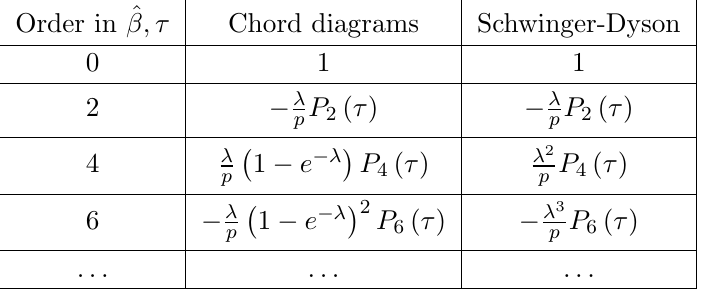
Table 2. Dominant contributions at small (cid:21) and p (cid:0) 1 for the high temperature, low time regime of the two-point function of a single fermion i in SYK. The polynomials P i ( (cid:28) ) have been introduced to keep the notation compact. Their expressions are: P 2 ( (cid:28) ) (cid:17) ^ (cid:12)(cid:28) , P 4 ( (cid:28) ) (cid:17) ^ (cid:12)(cid:28) (^ (cid:12) 2 + 3^ (cid:12)(cid:28) + (cid:28) 2 ) = 6, P 6 ( (cid:28) ) (cid:17) ^ (cid:12)(cid:28) (9^ (cid:12) 4 + 45^ (cid:12) 3 (cid:28) + 80^ (cid:12) 2 (cid:28) 2 + 45^ (cid:12)(cid:28) 3 + 9 (cid:28) 4 ) =